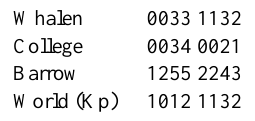
Table 3. Geomagnetic indices, K and Kp (26 October